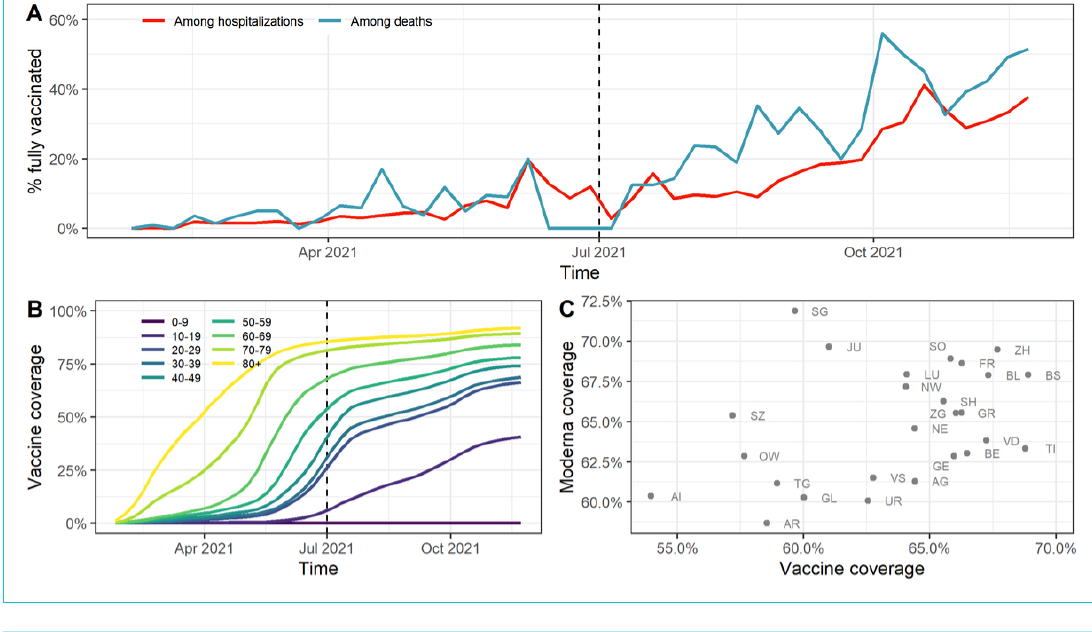
Figure 1: (A) Proportion of hospitalised and deceased COVID-19 patients reported as fully vaccinated among all reported COVID-19-related hospitalisations and deaths. The dashed vertical line corresponds to the starting date of the analysis. (B) Evolution of SARS-CoV-2 vaccine coverage in the population by age group. (C) Cantonal differences regarding the overall SARS-CoV-2 vaccine coverage and the proportion of fully vaccinated individuals having received the Moderna vaccine in the population (as of one week before the end of the study period).